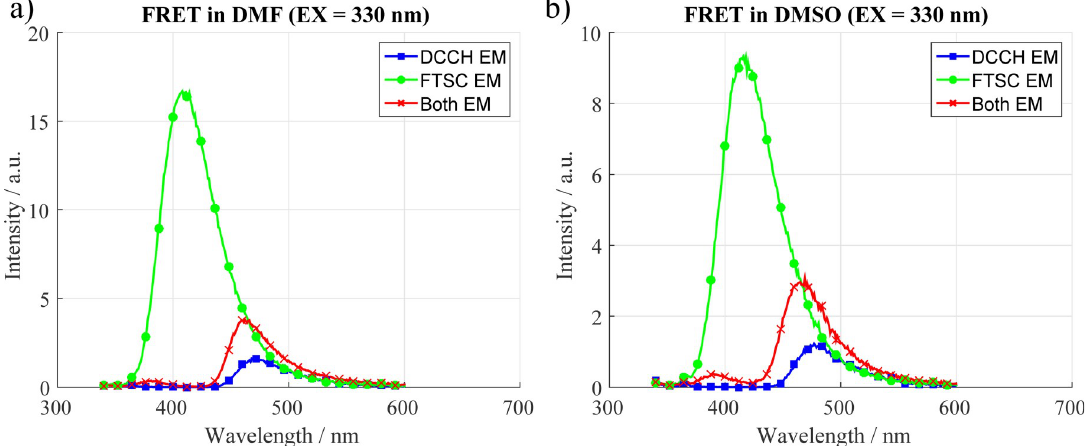
Fig 5. Fluorescence measurements with a concentration of 0.1 mM. When the dyes are mixed together the FTSC fluorescence is quenched and the DCCH fluorescence is enhanced which is a clear sign of FRET.